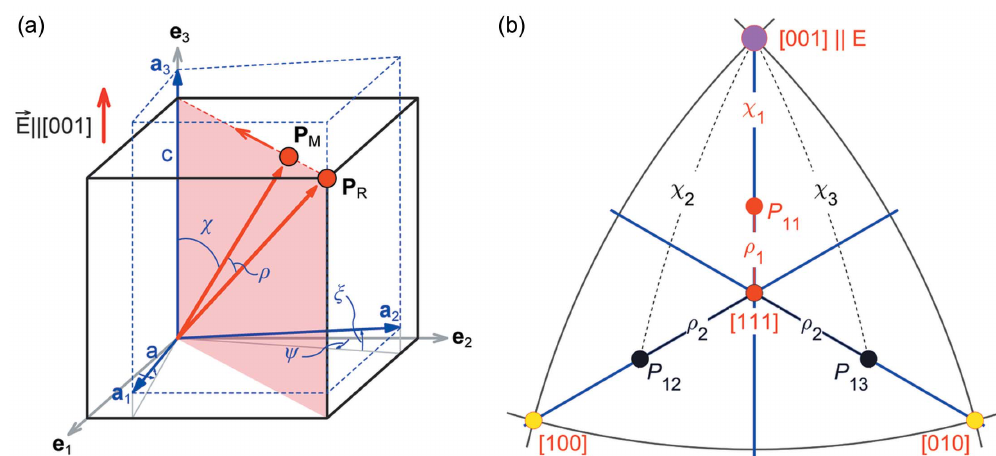
Figure 5 The distortion of the monoclinic unit cell and the polarization rotation. ( a ) A schematic showing the monoclinic distortion of the pseudocubic unit cell due to the rotation of the polarization direction. The angle between the polarization vector and the cell-body diagonal is (cid:10) . The unit cell is modelled using four (cid:10) -dependent parameters ( c , a , and (cid:9) ): c and a are the lengths of the unit-cell edges in and out of the polarization rotation plane, respectively, and and (cid:9) are the unit-cell shear angles. ( b ) A stereographic projection of polarization rotation planes and directions of polarization P 11 , P 12 and P 13 in the monoclinic domains M 11 , M 12 and M 13 , respectively. An animated version of panel ( a ) is available in the supporting